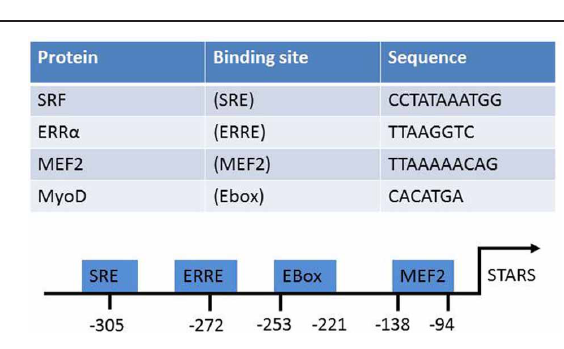
Over expressing peroxisome proliferator-activated receptor- γ coactivator-1 α (PGC-1 α ), with and without the shRNA knock- down of ERR α in C2C12 myotubes, demonstrated that STARS is under the control of a PGC-1 α /ERR α transcriptional program. STARS can also regulate its own transcription via a feed-forward mechanism that requires SRF binding to the serum response element (SRE) on the STARS promoter (Chong et al., 2012). Conversely, STARS is repressed in embryonic, neonatal, and adult hearts by GATA4 (Ounzain et al., 2012). Depletion of GATA4 allows the pathological up regulation of STARS (Ounzain et al.,